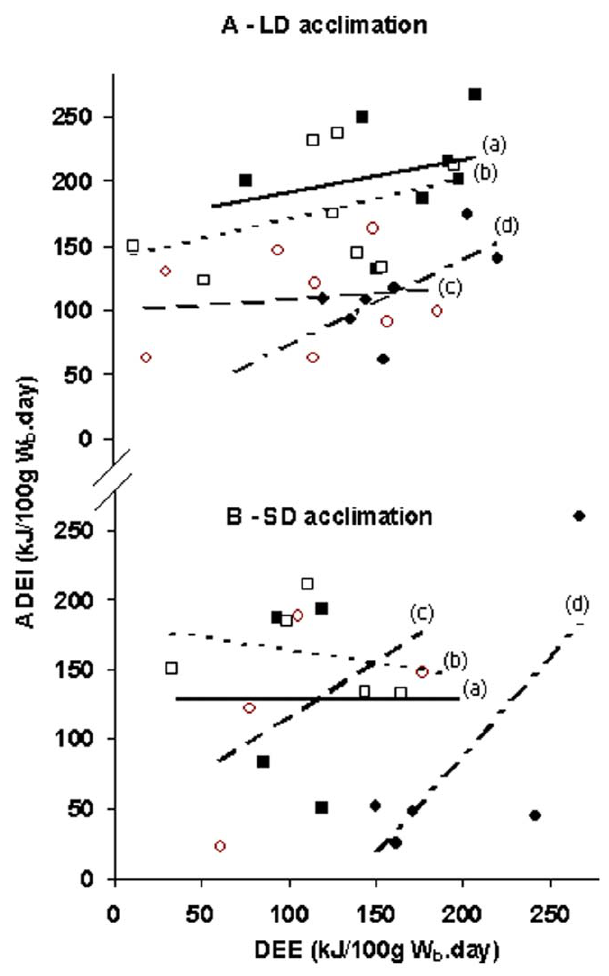
Figure 4. Energy intake and energy expenditure. Energy intake (Apparent digestible energy intake, ADEI , kJ/100 g W b .day) measured by food intake and faecal output against energy expenditure ( DEE , kJ/ 100 g W b .day) measured by oxygen consumption for Mount Carmel ( MC ) and Mount Hermon ( MH ) A. mystacinus acclimated to ( A ) long day ( LD ; 16L:8D) and ( B ) short day ( SD ; 16D: 8L) photoperiod regimes. 0.9% salinity MC mice are denoted by solid squares and a solid line (‘a’); 0.9% salinity MH mice are denoted by open squares and a dotted line (‘b’); 1.8% salinity MH mice are denoted by open circles and a hashed line (‘c’) and 1.8% salinity MC mice are denoted by solid circles and a dot-hashed line (‘d’). ‘‘/100 g W b .day’’ denotes per 100 g body mass per